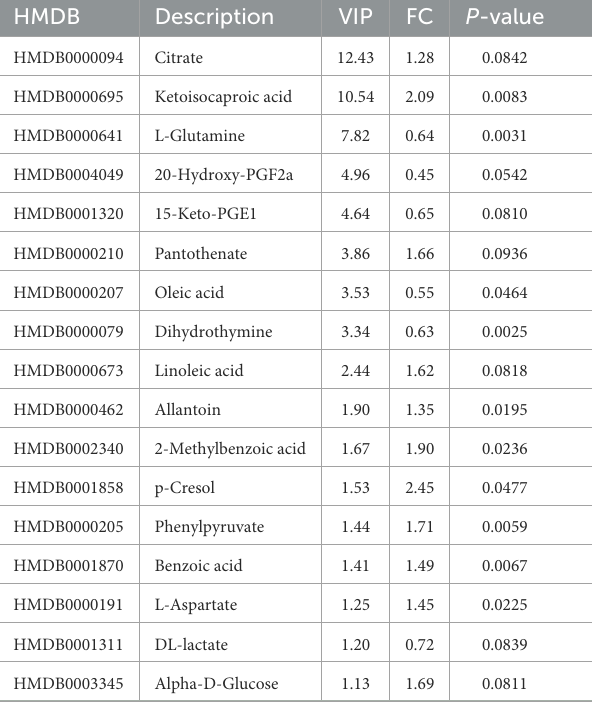
TABLE 3 Differential metabolites between the LF and HF groups in the positive ion mode.